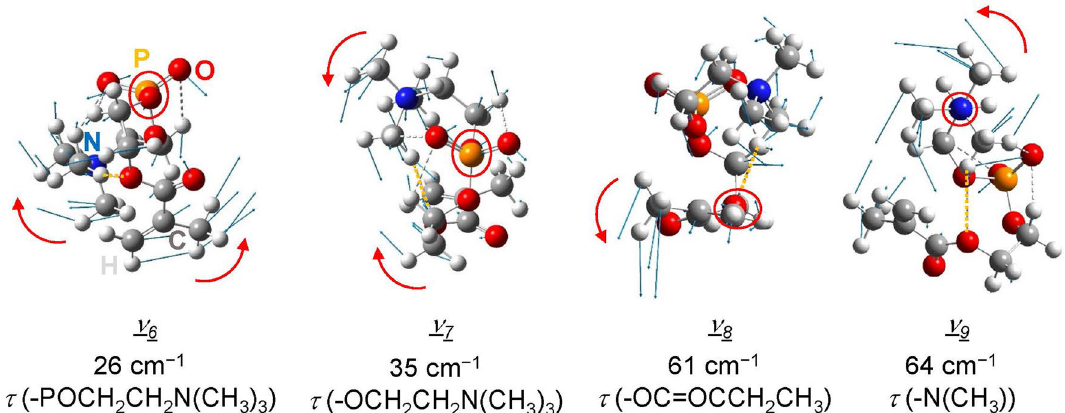
Figure 6. Vibrational modes given as ν 6 – ν 9 in Fig. 5 ( τ : torsion). The frequency of each mode is the result calculated with a dielectric constant of 4.20. The blue arrows indicate the atomic displacement vectors. Intramolecular hydrogen bonds are indicated by the dashed lines, and the orange dashed line is the hydrogen bond HB4 given in Fig. 4a. The red circle represents the two atoms that form the torsion axis, and the movement around the torsion axis is indicated by the red